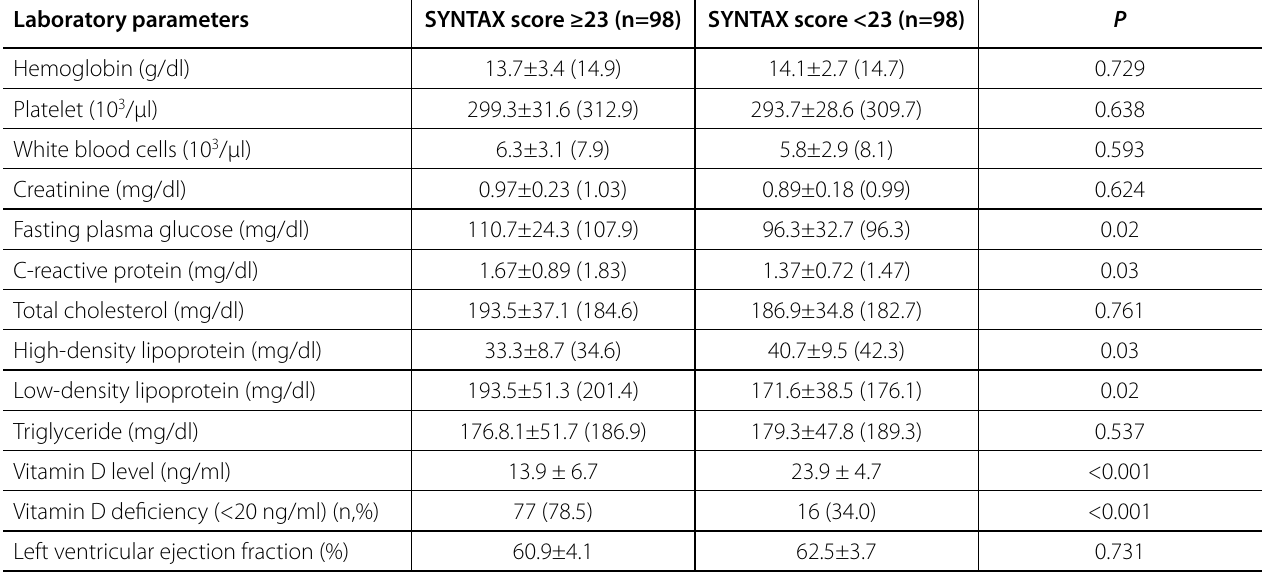
Table 2. Laboratory and echocardiographic parameters of the study